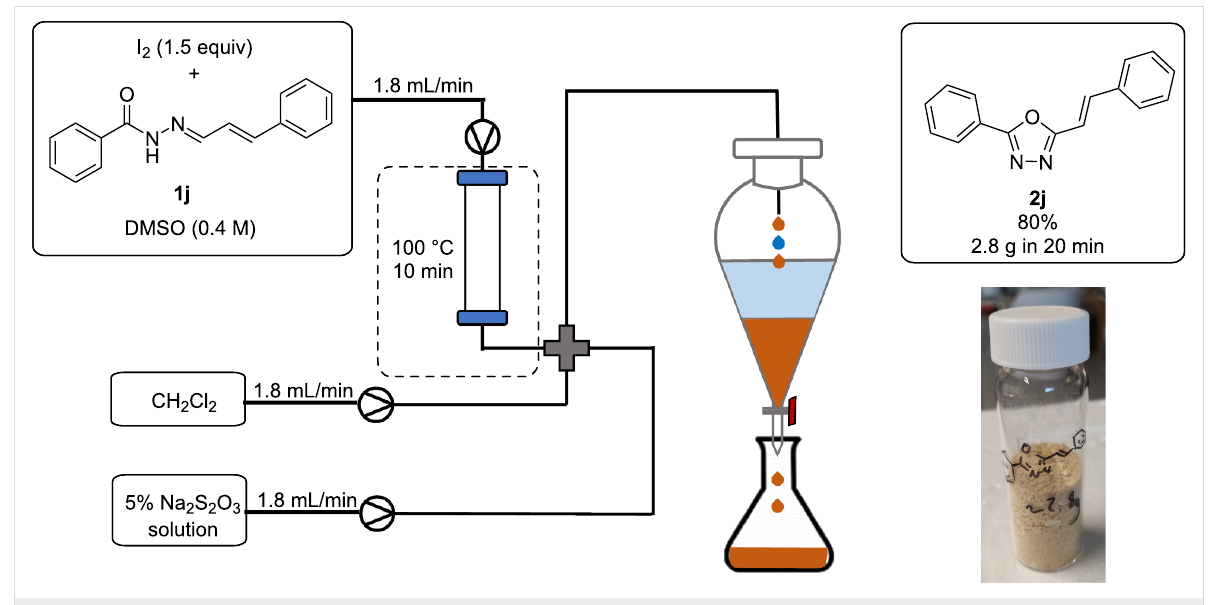
Scheme 5: Continuous flow scale-up reaction with in-line quench and